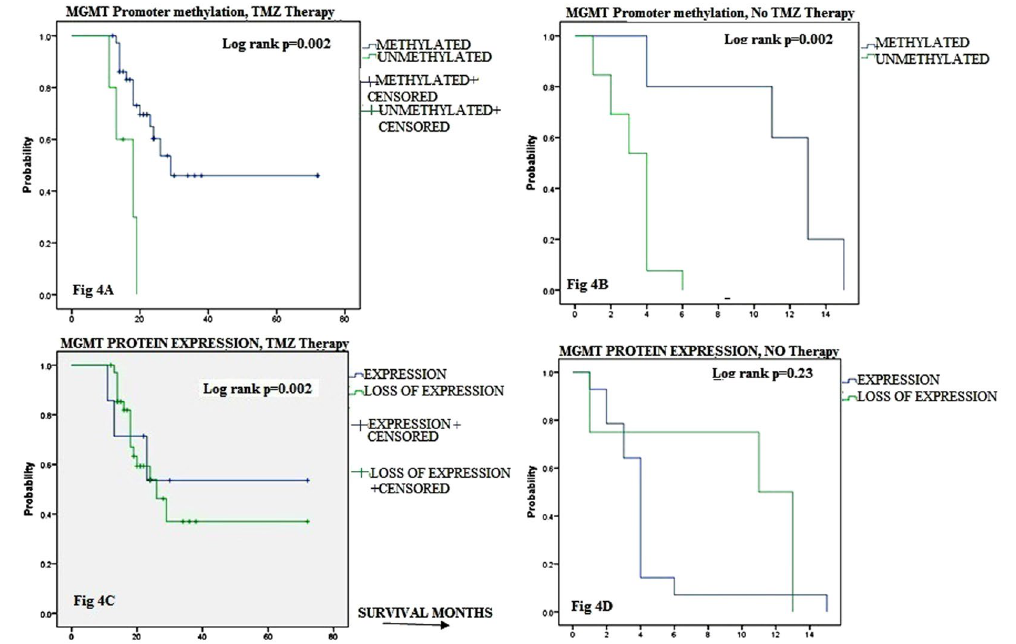
Figure 4. Comparison of MGMT promoter methylation and protein expression with overall survival (OS) of patients. KM analyses of OS for MGMT promoter methylation ( A , B ) or MGMT protein expression ( C , D ) of Glioma treated ( A , C ) and untreated ( B , D ) with TMZ therapy.